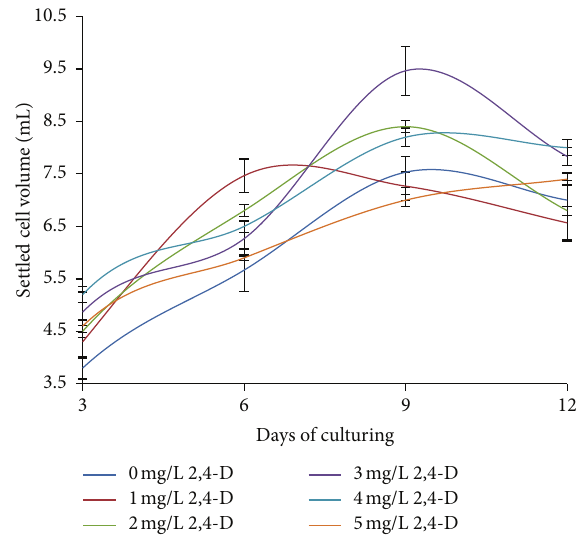
Figure 1: Effects of different concentrations of 2,4-D on the establishment of the Mitragyna speciosa cell suspension culture as measured by the settled cell volume (mL) in 25 mL of cell culture. The bars indicate the standard